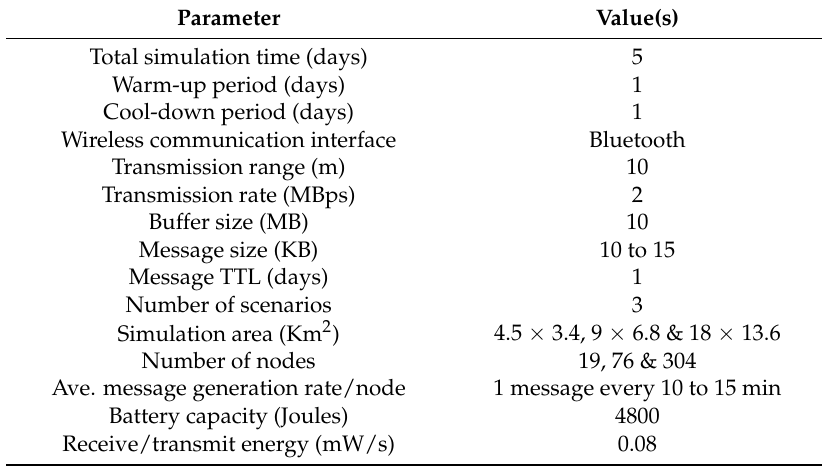
Table 1. Simulation parameters for the small, medium and large